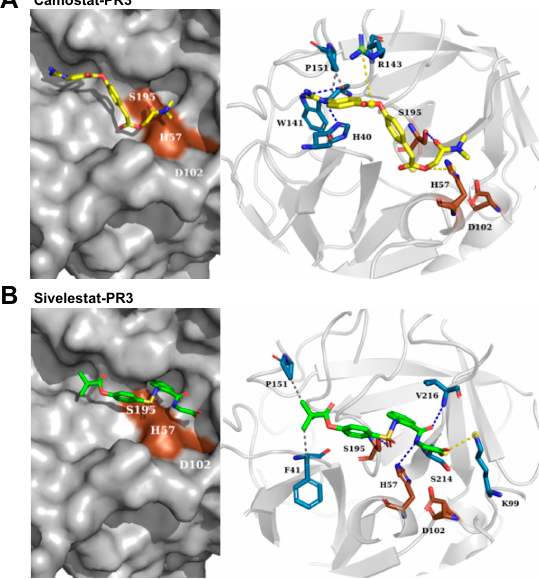
Figure 5. A molecular docking approach was used to determine the binding affinity of camostat and sivelestat to PR3. ( A ) The predicted poses for camostat (yellow) to PR3 (1FUJ) exhibited three hy- drogen bonds (H40, W141, and S195), one hydrophobic (P151), and two salt bridges (H57 and R143). ( B ) The ligand-binding affinity prediction of sivelestat (green) results in four hydrogen bonds to PR3 (H57, S195, S214, and V216), two hydrophobic (F41 and P161), and one salt bridge (K99). The catalytic triad (brown), the surface model of NE (grey), blue dashed lines refer to hydrogen bonds, hydrophobic interactions (grey dashed lines), and salt bridges (yellow dashed lines).